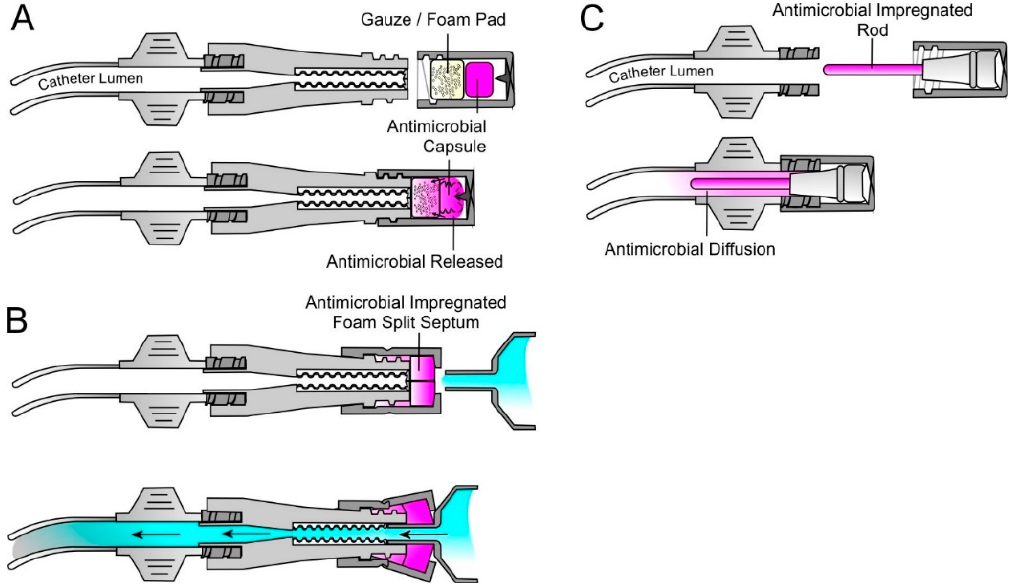
Figure 4. Needle free connector barrier caps based on simple foam insert ( A ), an encapsulating split septum ( B ) and the Clearguard ® terminal cap ( C ).